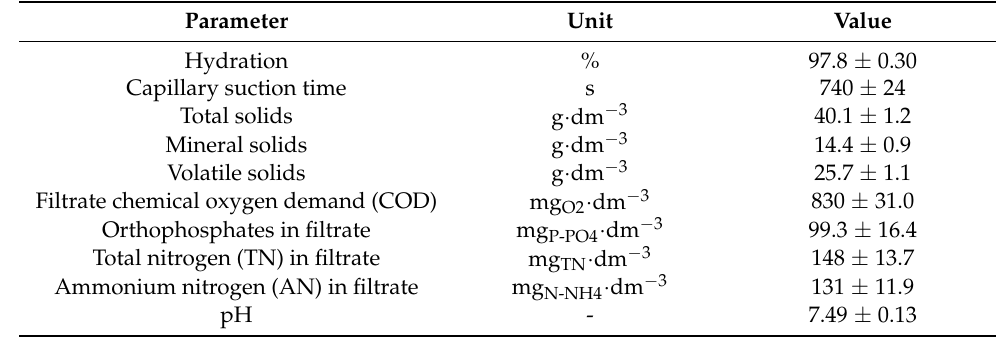
Table 3. Characteristics of the anaerobic inoculum used in the study.